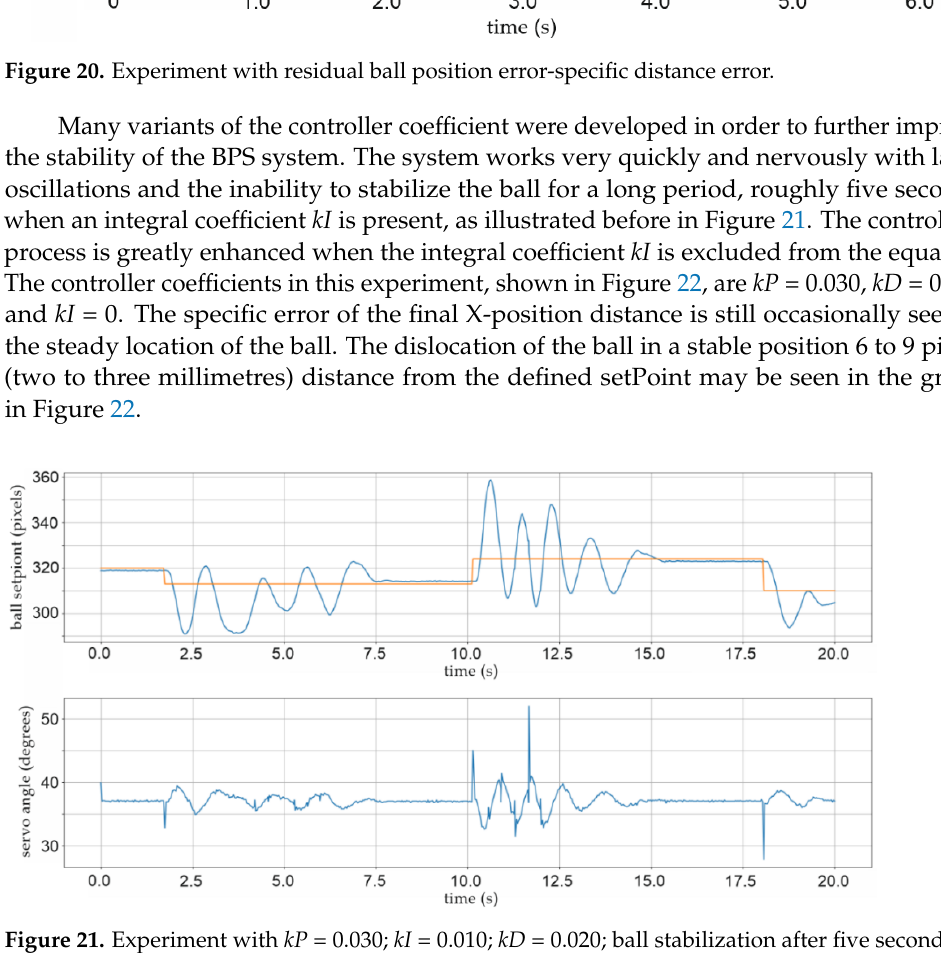
Figure 21. Experiment with kP = 0.030; kI = 0.010; kD = 0.020; ball stabilization after five seconds.